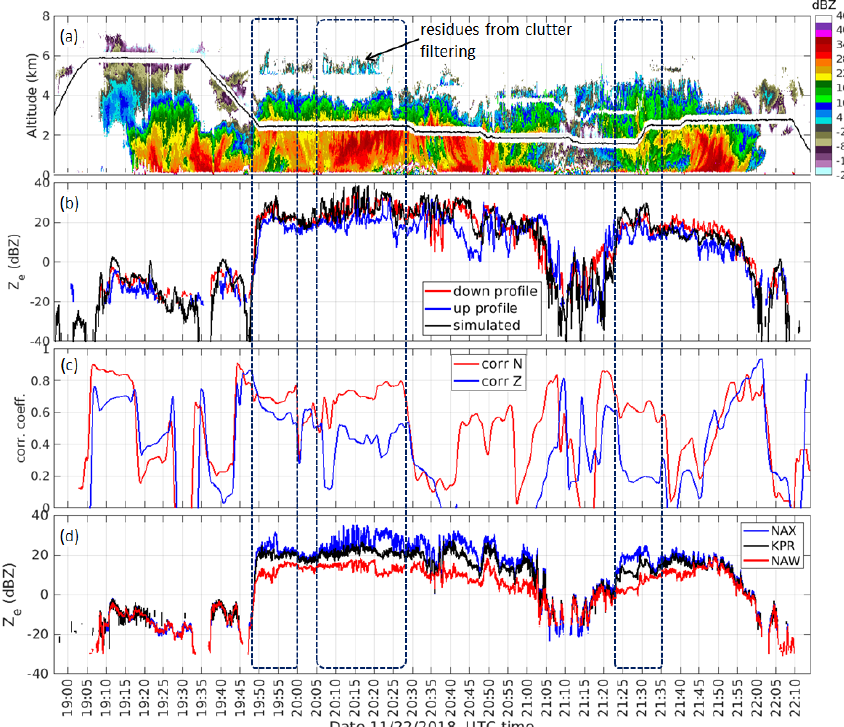
Figure 8. (a) X-band vertical cross section reflectivity for the 22 November flight; (b) reflectivity profiles at 245m above and below the aircraft along with X-band reflectivities calculated from the measured PSDs; (c) correlation coefficients between the above and below reflectivity and simulated reflectivity; (d) reflectivity profiles of X-, Ka-, and W-band radar at 245m below the aircraft showing the regions with interesting triple-frequency radar signatures. Boxes indicate the specific segments that will be analyzed further.